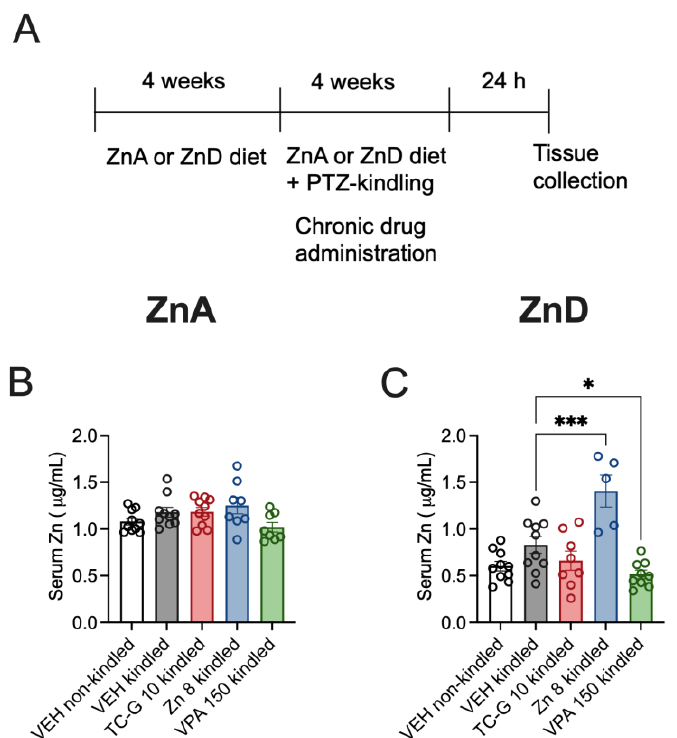
Figure 5. Chronic effects of TC-G 1008 (TC-G) (10 mg/kg), ZnCl 2 (8 mg Zn/kg), or VPA (150 mg/kg) and the PTZ-kindling model of epilepsy on the total zinc concentration in the sera of mice fed the ZnA or ZnD diet. ( A ) Experimental paradigm. Mice were fed the ZnA or ZnD diet for 4 weeks. Following a 4-week dietary zinc restriction, the PTZ-kindling model of epilepsy began. The model consisted of 13 injections of PTZ (40 mg/kg). Non-kindled mice received VEH and physiological saline, instead of PTZ. The ZnA or ZnD diet was continued during this chronic paradigm. The serum samples were obtained 24 h after the last injection of PTZ. Total serum zinc concentration was meas- ured by ICP-OES. ( B , C ) Data are expressed as means ± SEM. They were analyzed by one-way ANOVA and the Dunnett’s multiple comparison test. n = 5 – 10 in each group. Statistical details: ( B ) F(4,41) = 2.564, p = 0.0525 ( C ) F(4,37) = 12.15, p < 0.0001 (B-C one-way ANOVA). * p < 0.05, *** p < 0.001 vs. VEH kindled group (Dunnett’s multiple comparison